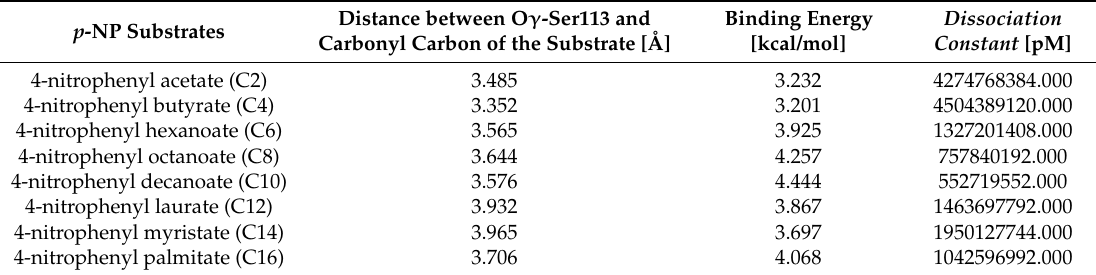
Table 4. Molecular docking of rHZ Lipase with the different p -nitrophenyl substrate using YASARA software.